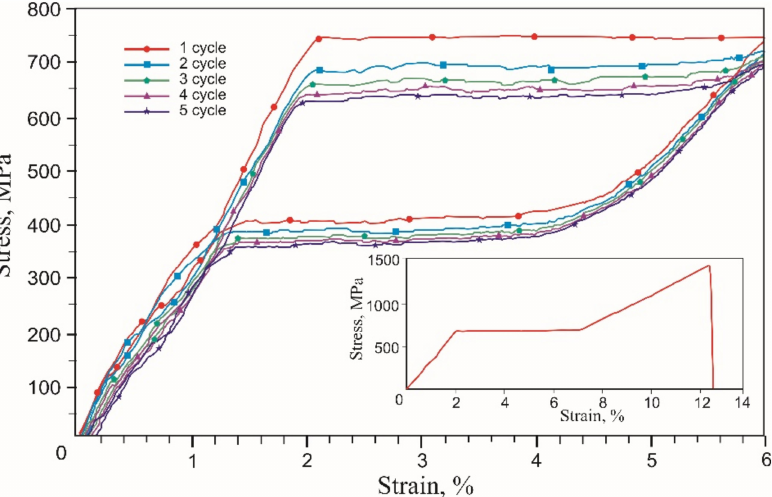
Figure 10. Engineering tensile stress-strain curves of the 60 µ m NiTi wire 5 loading-unloading cycles and uniaxial tension to fracture